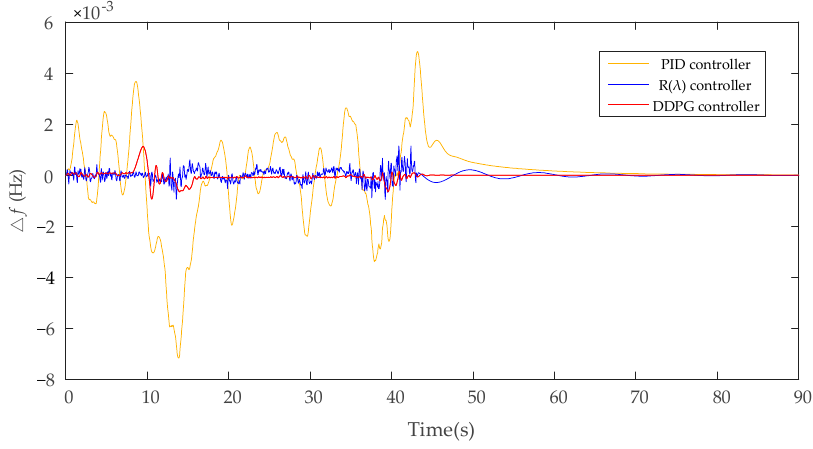
Figure 13. Performance of frequency control under wind power disturbance.